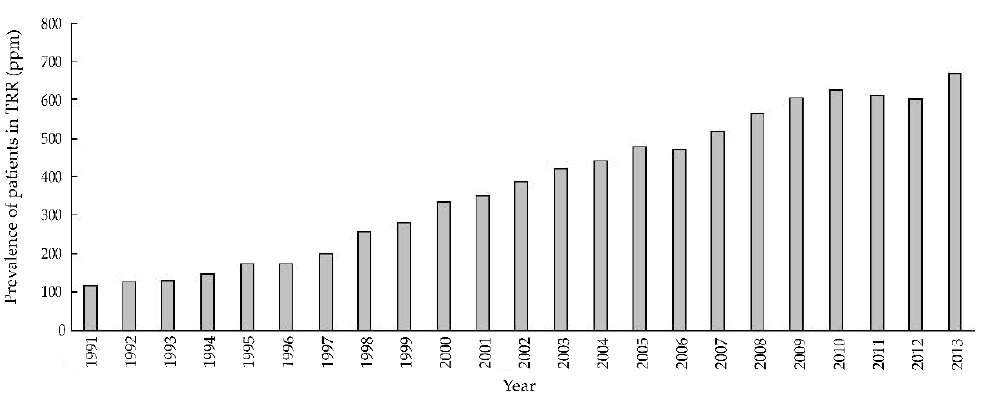
Figure 2. Prevalence of renal replacement therapy in Latin America, 1991−2013. This figure shows a steady increase in prevalence of renal replacement therapy over recent ~25 years in Latin America. Reprinted from “Latin American Dialysis and Transplant Registry: Experience and contributions to end-stage kidney disease epidemiology” [5].